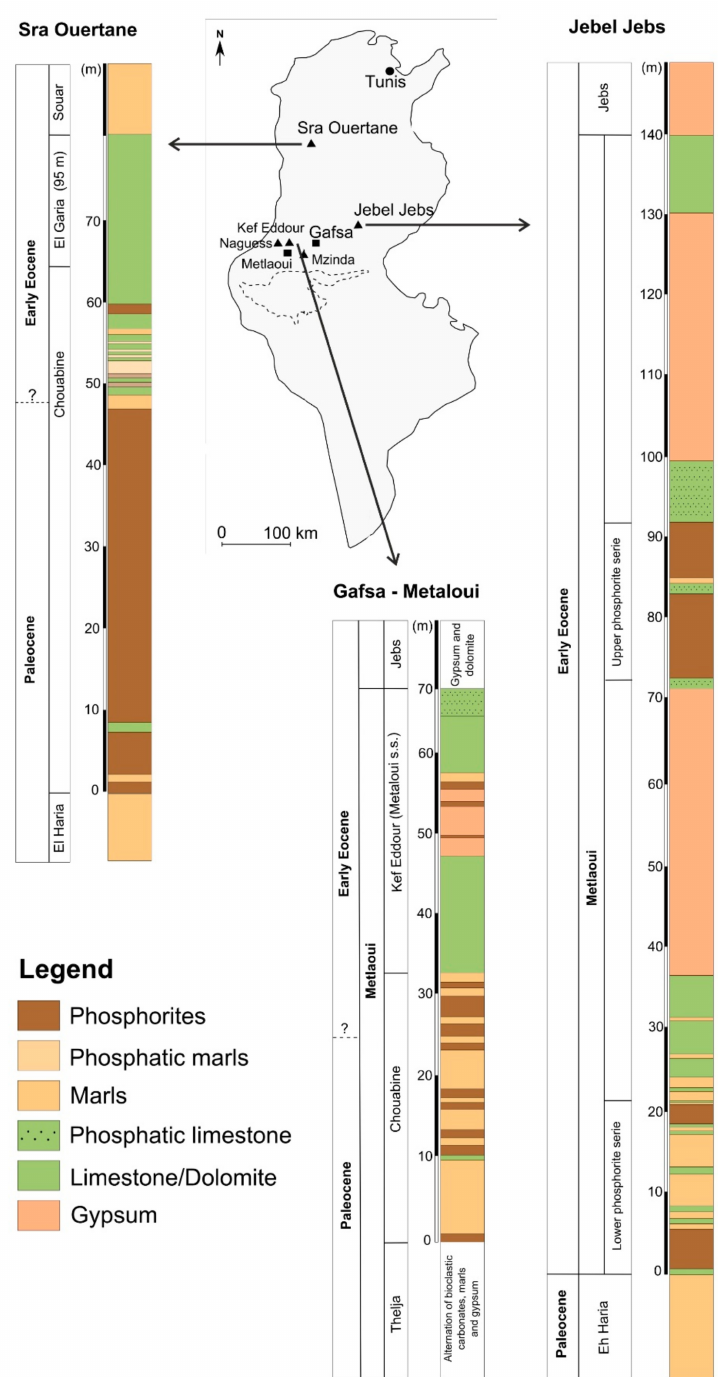
Figure 4. Stratigraphical columns of the phosphorite-bearing sequence of the studied Tunisian basins. Gafsa-Metlaoui basin and Jebel Jebs modified after [36]; Sra Ouertane modified after